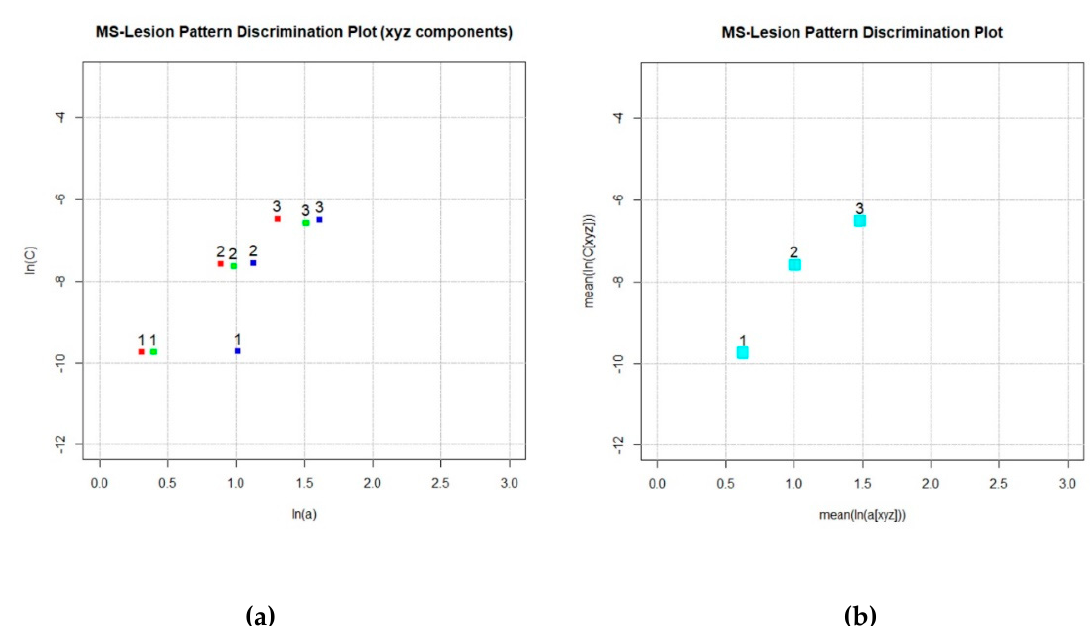
Figure 3. ( a ) Component MS-LDP, ln( a [x,y,z]) vs. ln( c [x,y,z]) for MS-WML: MNI_mild (label = 1), MNI_moderate (label = 2) and MNI_severe (label = 3). Each MS-WML geometry is expressed by x, y, z directional variogram model parameters, indicated by red, green, blue squares. For MNI_mild, a strong anisotropy according to MS-lesions stretched in z direction is indicated by relatively higher ln( a [z]). ( b ) MS-LDP, mean (ln( a [xyz]) vs. mean (ln( c [xyz]) for MNI_mild (label = 1), MNI_moderate (label = 2) and MNI_severe (label = 3). MS-lesion pattern (1, 2, 3) geometry is abstracted to one point each. This is useful to avoid overloading graphics when working with a larger number of MS-WML (e.g., [5,6], compare the real-world MS_LDP: LDP_Supplement.jpg , in Appendix A).